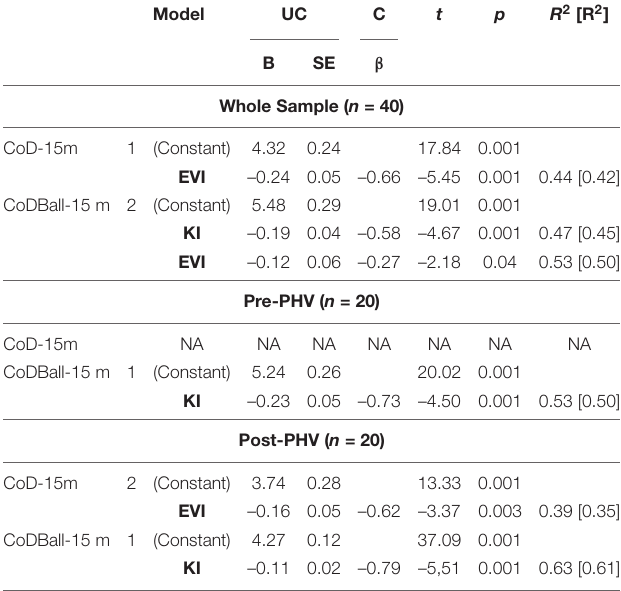
TABLE 4 | Stepwise linear regression analyses with measures of the CoD (CoD-15m and CoDBall-15m), as criterion variable and the three- dimensional structure of the MIQ-3f (IVI, EVI, and KI), as predictor variables in forty elite youth soccer players according to their maturity